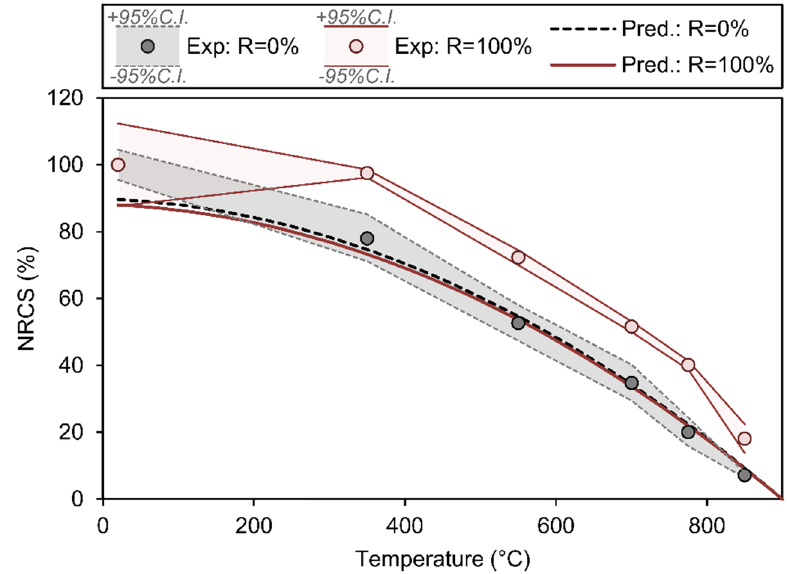
Figure 5. Experimental observations of concrete batches A0 (NAC, with R = 0%) and A100 (RAC, with R = 100%) and prediction models for R = 0% and R = 100%, based on a non-linear multiple variable regression analysis sourced from experiments reported here and in the state-of-the-art.